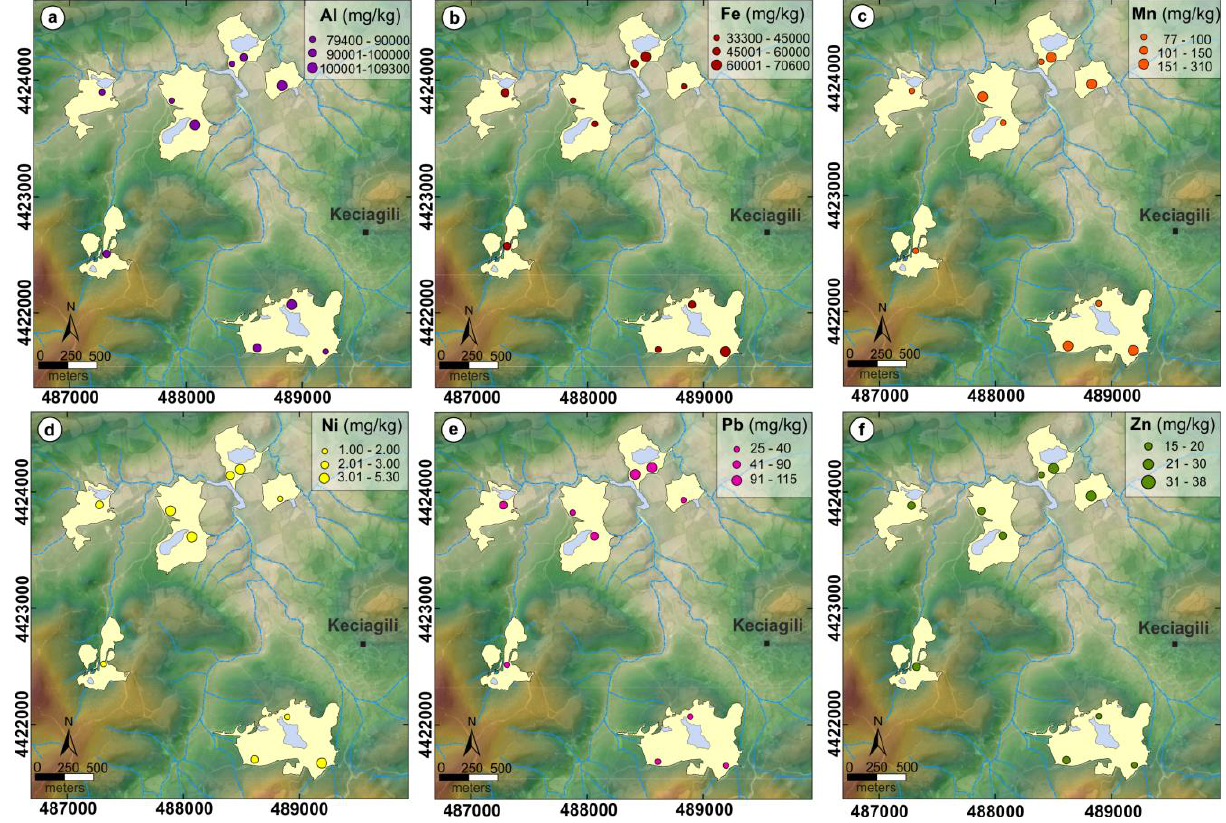
Figure 5. Metal concentration of mine wastes a. Al b. Fe c. Mn d. Ni e. Pb f.